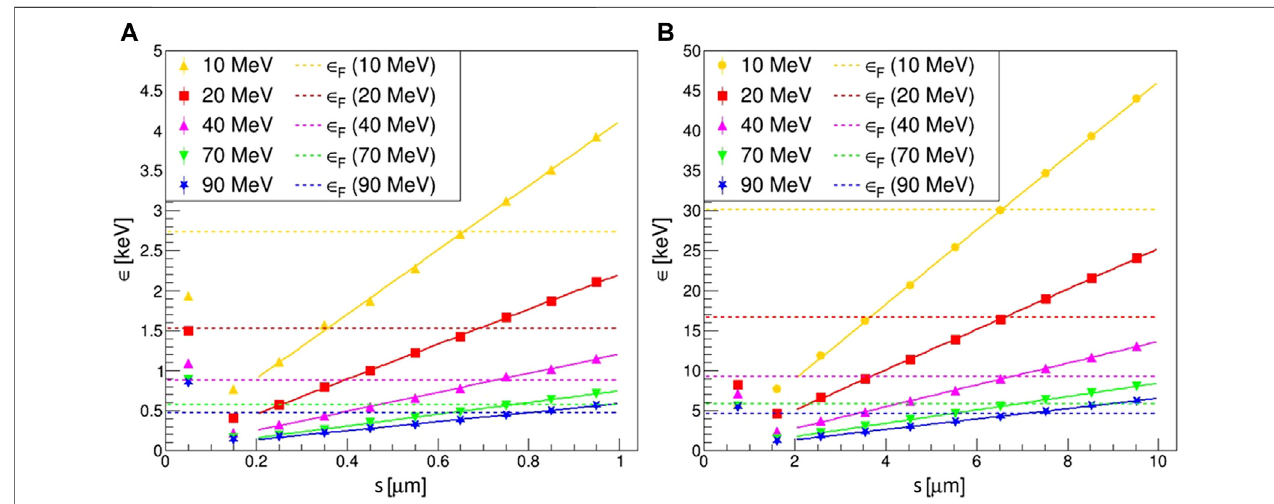
FIGURE 10 | Plot of the variation of the mean energy imparted per event, ϵ s , as a function of the proton trajectory length s , described in the site, obtained with weighted random sampling for the different energies and sites: (A) 1 μ m diameter; (B) 10 μ m diameter. For s ∼ 0, when proton tracks do not cross the site or pass tangent to it, the only contribution to ϵ s is given by δ -ray in fl ux. Then, for higher s , ϵ s increases linearly with the trajectory length. The frequency-averaged energies imparted per event (cid:1) ϵ sF obtained considering the full data set are represented in this plot as horizontal dashed lines, each colour corresponding to one proton energy. The intersection point of the linear fi t of ϵ s as a function of s with (cid:1) ϵ sF corresponds to the effective mean chord length (cid:1) l * F .